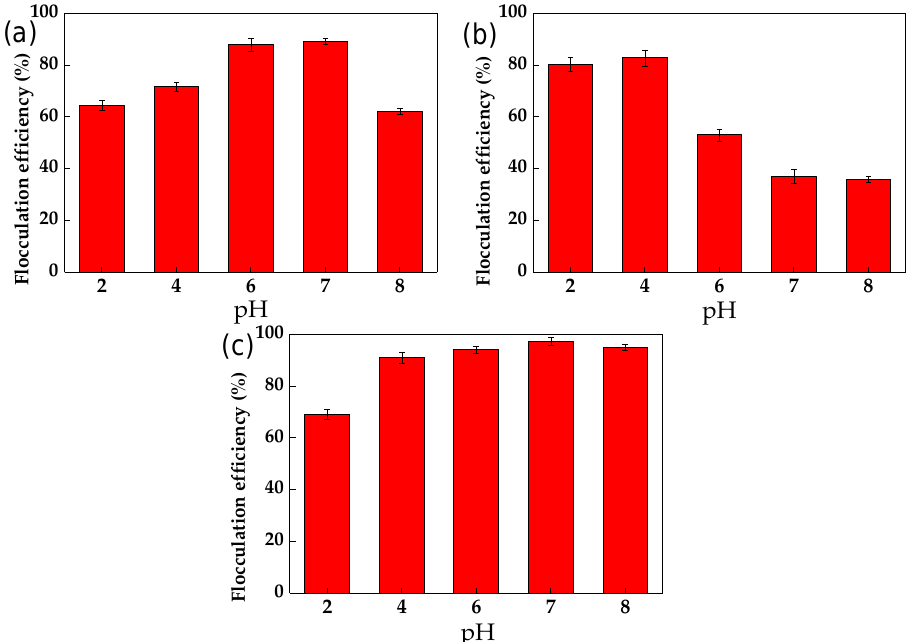
Figure 2. The effect of pH on the flocculation efficiency of C. vulgaris by chitosan ( a ); WPE ( b ); and chitosan and WPE ( c ). The error bars represent the standard deviation of the mean ( n = 3).